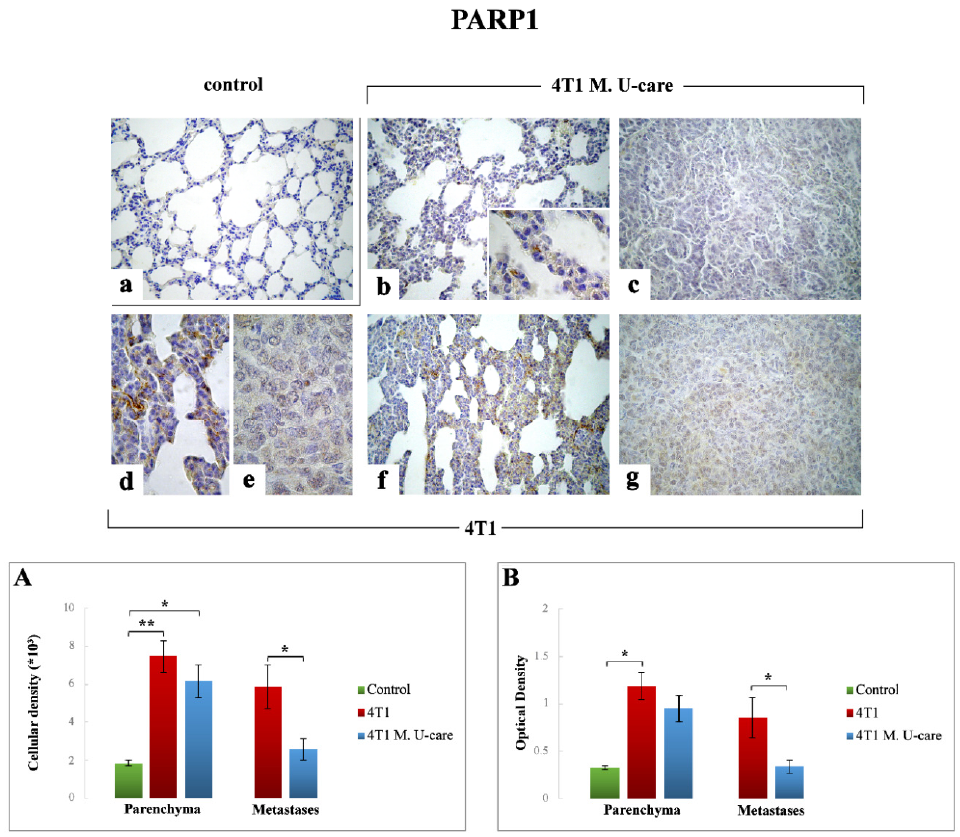
Figure 3. Immunostaining reaction for PARP1 in healthy control ( a ), 4T1 M. U-care ( b , c ) and 4T1 ( d – g ) mice. Light microscopy magnification: 40× ( a – c , f , g ); 100× ( d , e , insert in panel ( b )). Panels A and B : mice. Light microscopy magnification: 40 × ( a – c , f , g ); 100 × ( d , e , insert in panel ( b )). Panels ( A )